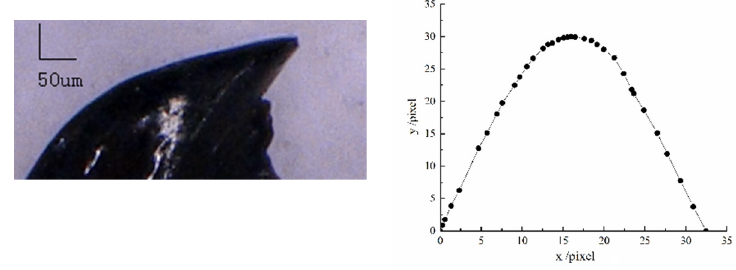
Figure 3. Incisor lobe of cricket and its fitted curve.